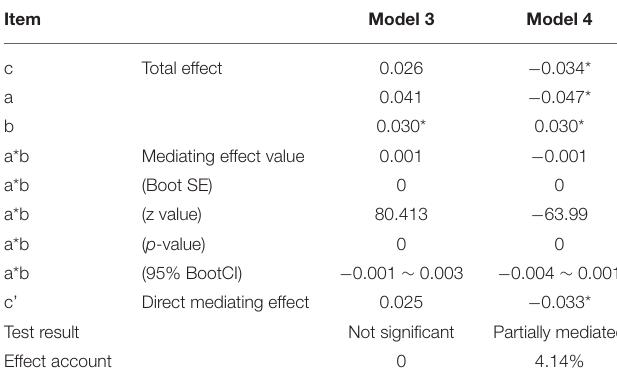
TABLE 7 | Results of mediating